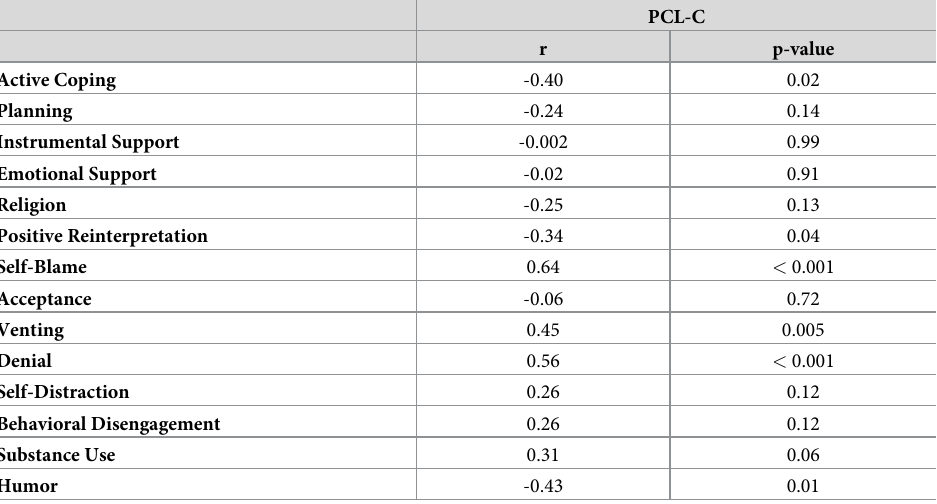
Table 3. Correlation analysis between coping styles and